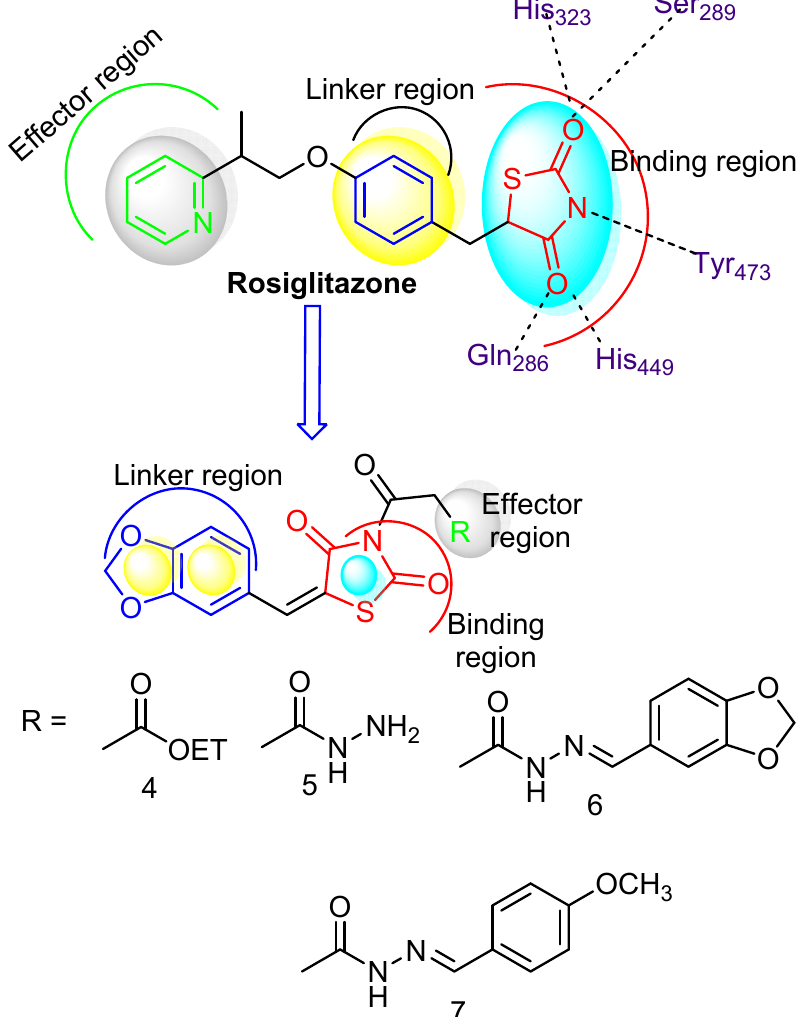
Figure 1. Designed molecule compliance of rosiglitazone pharmacophore .